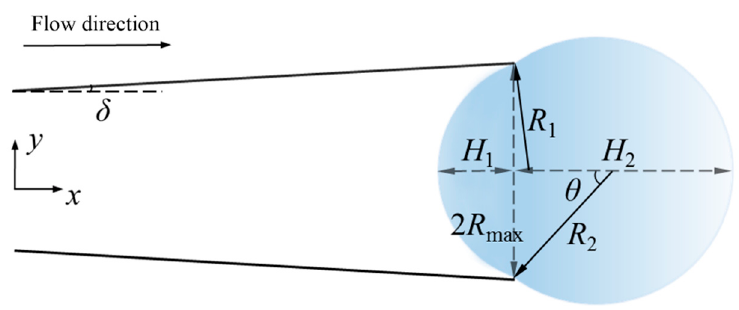
Figure 5. A schematic diagram of the ejection stage of the bubble at the opening of the micromotor.